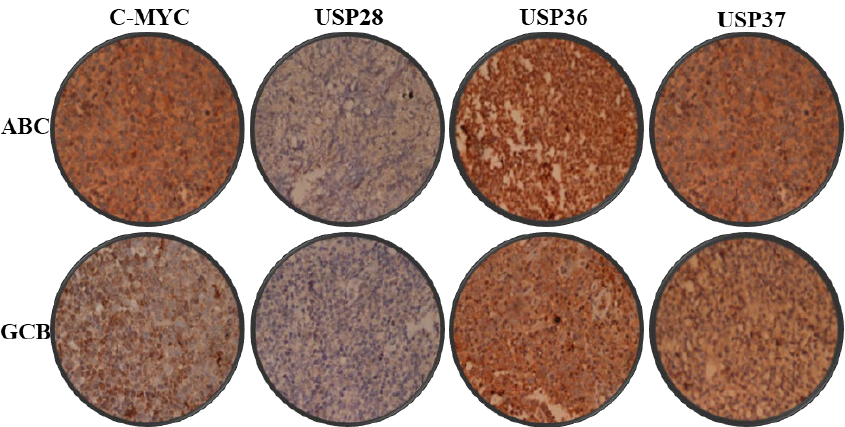
Figure 2. Immunohistochemistry of DLBCL samples. Representative histomicrographs (400×) of the ABC and GCB subtypes of DLBCL probed with c-MYC, USP28, USP36 and USP37 antibodies as labeled.